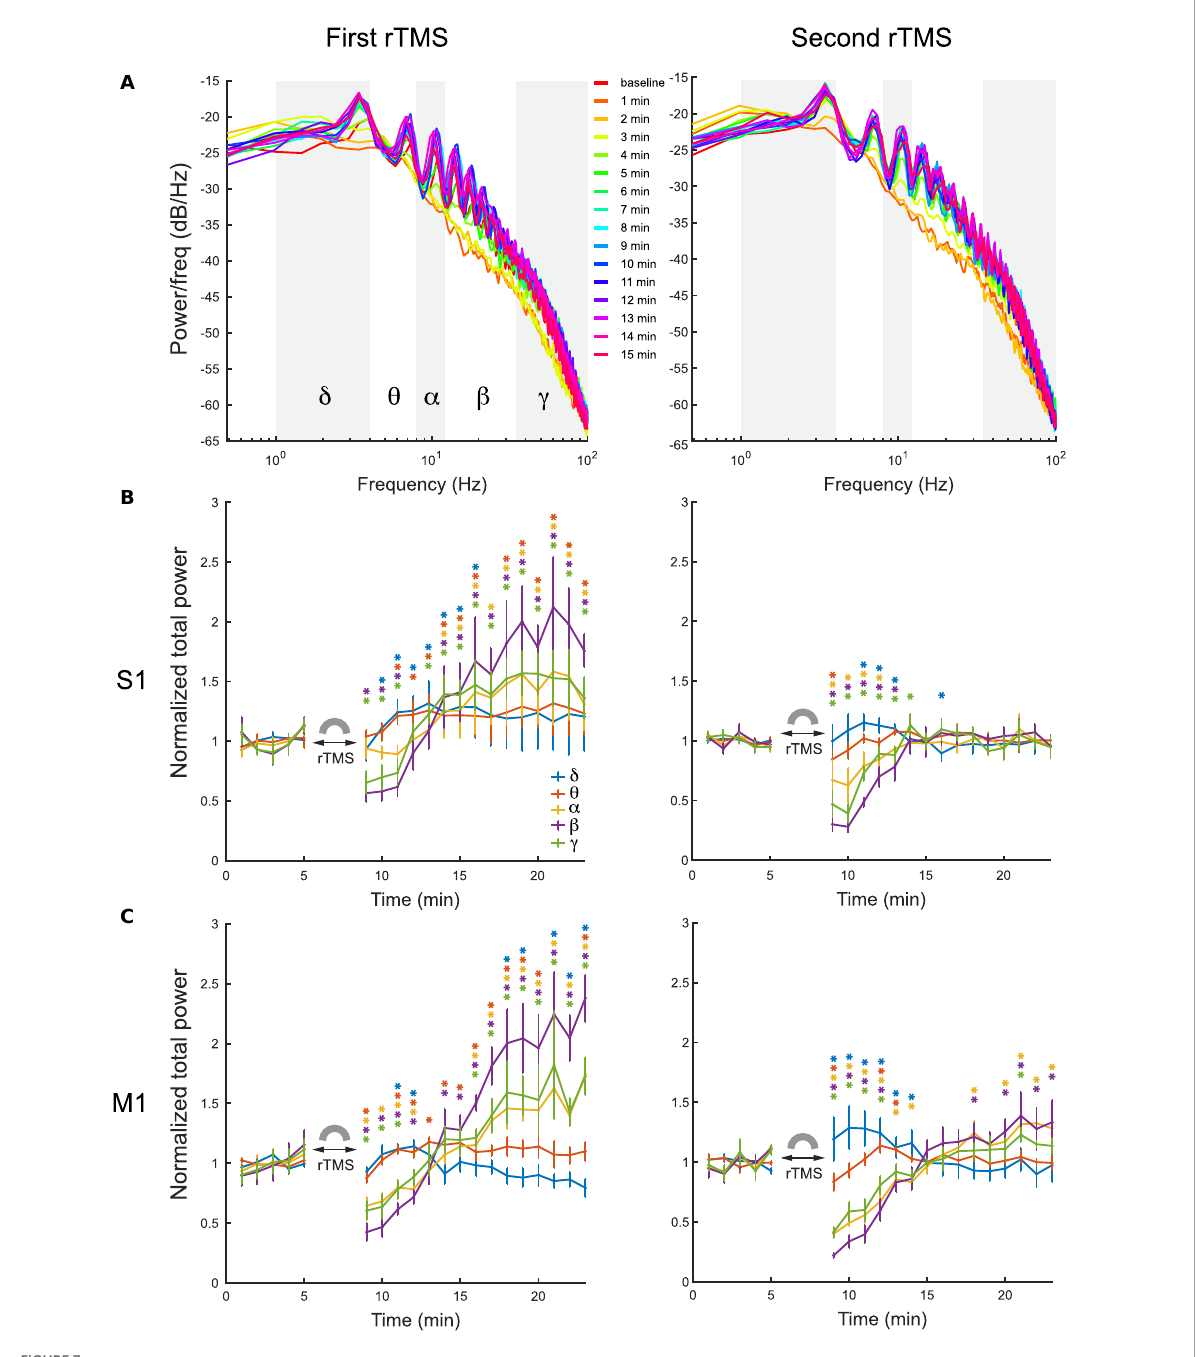
FIGURE7 Changes of LFP power distribution in different frequency bands in the S1 and M1 after each course of rTMS. (A) Power spectra at every minute before and after two courses of rTMS (Rat01). The mean power of delta (1–4 Hz), theta (4–8 HZ), alpha (8–12 Hz), beta (12–35 Hz), and gamma (35–100 Hz) bands are calculated and compared with the baseline level (* p < 0.05, two-tailed t -test). (B) The mean power of each frequency band in the S1 before and after each course of stimulation ( n = 5). (C) The mean power of each frequency band in the M1 before and after each course of stimulation ( n = 5). Error bars: